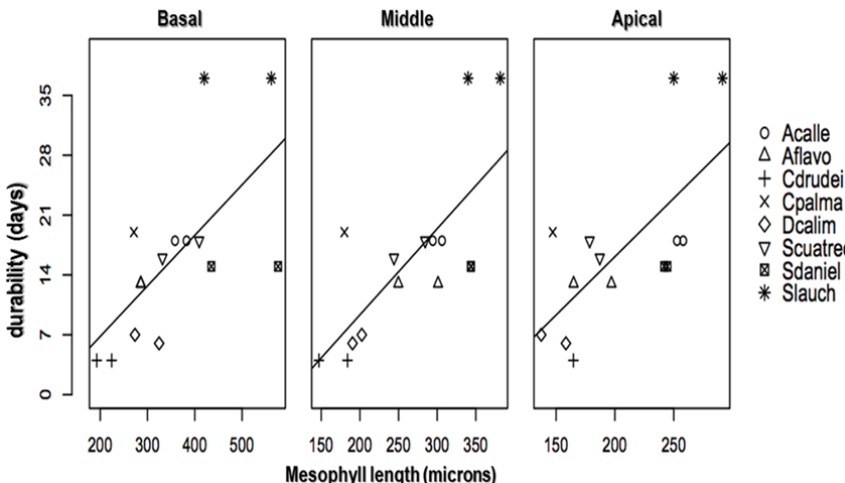
Figure 3 - Relationship between the mean values of mesophyll thickness and durability in vase for eight species of Cyclanthaceae. See names of each species in Table